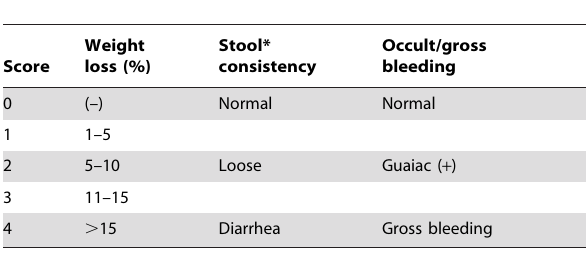
The disease activity index=(combined score of weight loss, stool consistency, and bleeding)/3. *Normal stools: well formed pellets; loose: pasty stools that do not stick to the anus; diarrhea: liquid stools that stick to the anus.